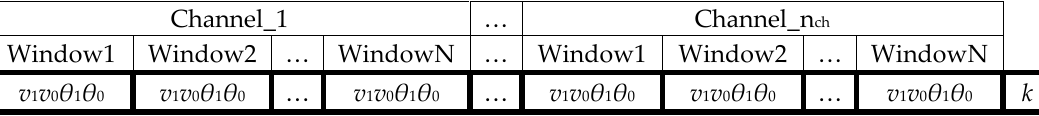
Figure 4. Structure of a chromosome containing the classification parameters.